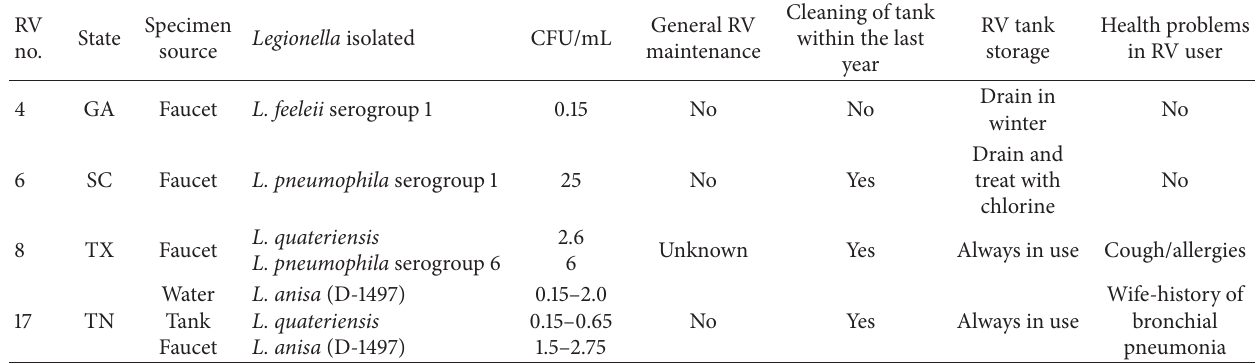
Table 1: Legionella spp. isolated, demographics, maintenance, and associated respiratory health issues of RVs positive for Legionellae. RV Specimen State no.